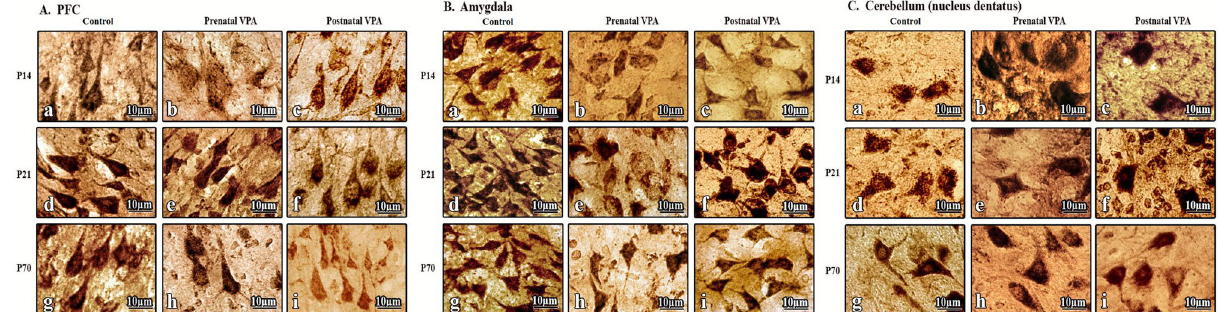
Figure 3. Morphological changes in brain target structures after prenatal and postnatal VPA administration compared to control group. ( A ) After the prenatal administration of VPA on PND 14(b), PND21(e), PND70(h) swollen pyramidal neurons with central chromatolysis and weak staining were found in prefrontal cortex. After the postnatal administration of VPA on PND 14(c), PND21(f), PND70(i) normal pyramidal neurons with centrally located nucleus and long dendrites were found. ( B ) After the prenatal administration of VPA on PND 14(b), PND21(e) swollen pyramidal neurons with central chromatolysis and weak staining were found in amygdala, on PND70(h) structural changes are not pronounced. After the postnatal administration of VPA on PND 14(c), PND21(f), PND70(i) normal pyramidal neurons with centrally located nucleus and long dendrites were found. ( C ) No morphological changes were observed on tested days in cerebellum. Magnification: × 1000 ( A – C